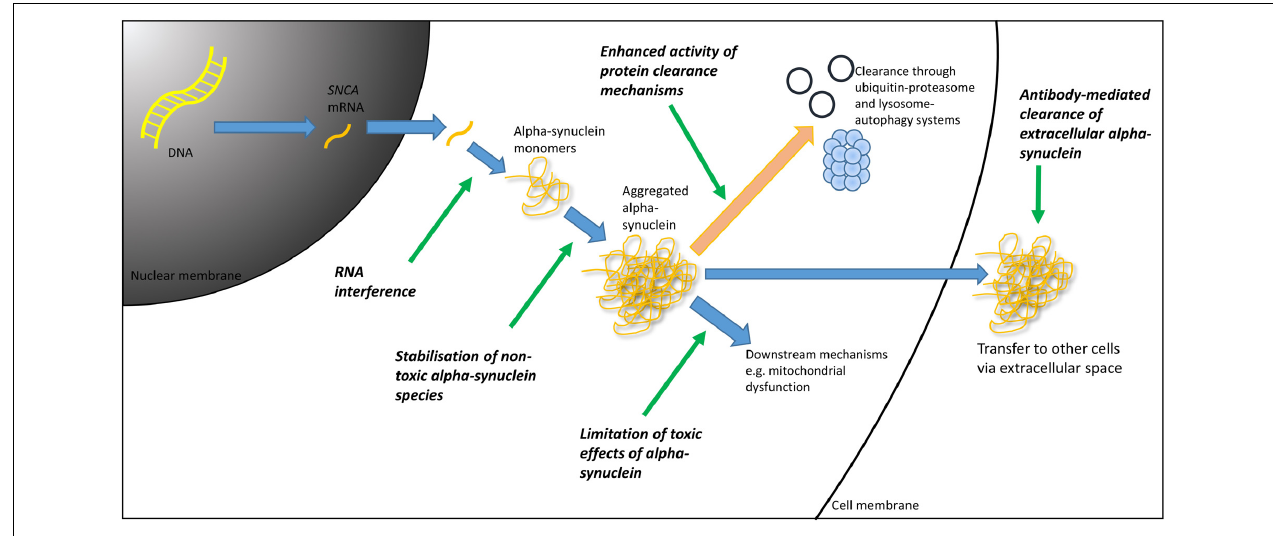
FIGURE 1 | Therapeutic targets in α -synuclein mediated pathology. DNA, deoxyribonucleic acid; mRNA, messenger ribonucleic acid; RNA, ribonucleic